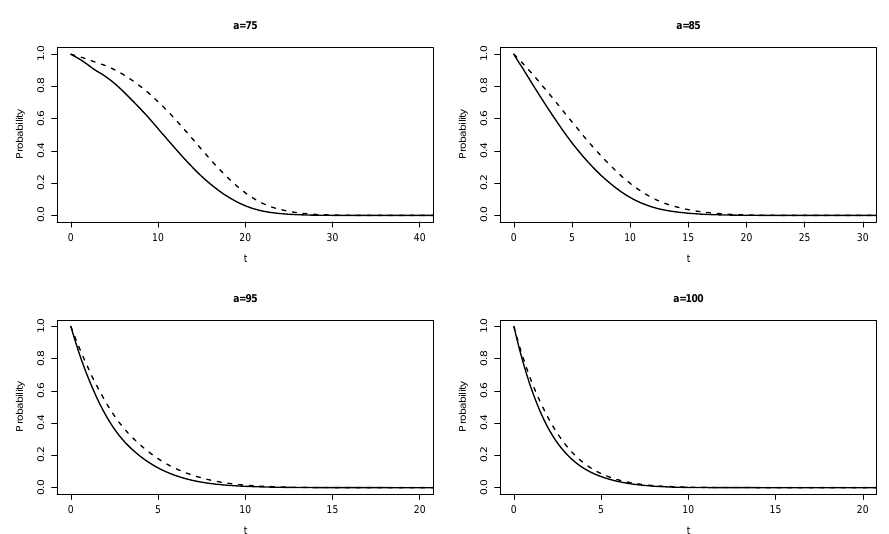
Figure 3. t P a for the year 2017 estimated from Beta Transformed Kernel Estimator (BTKE), for men (solid line) and women (dashed line), with a = 75,85,95,100. Usually, the value of w is determined by the mortality rate or its projection. It normally corresponds to an age at which all individuals have died. Considering that longevity